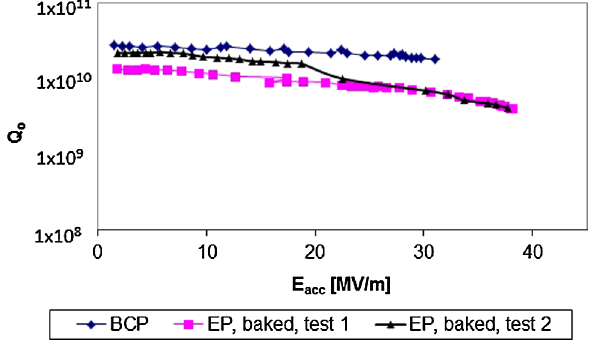
FIG. 42. Radio-frequency performance of TESLA shape single-cell cavity produced at company Butting by hydroforming. RRR250, radio-frequency tests done at JLab, EP done at